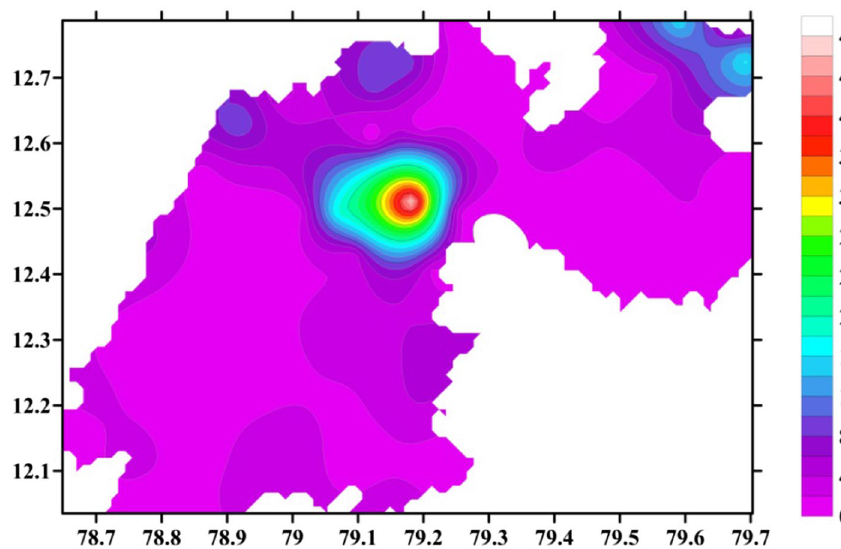
Fig. 22 Spatial variation of annual whole body dose in adult